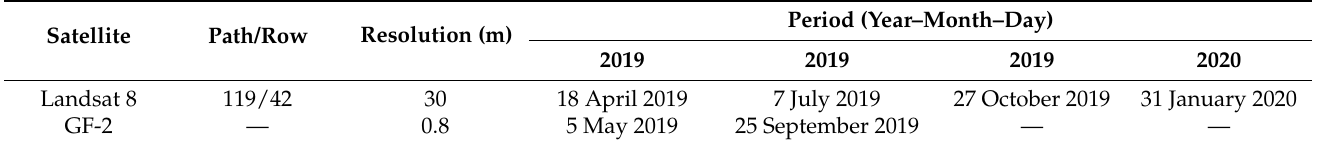
Table 1. Information on remotely sensed data for Jiaozuo in this Table 1. In f ormation on remotely sensed data for Jiaozuo in this study.